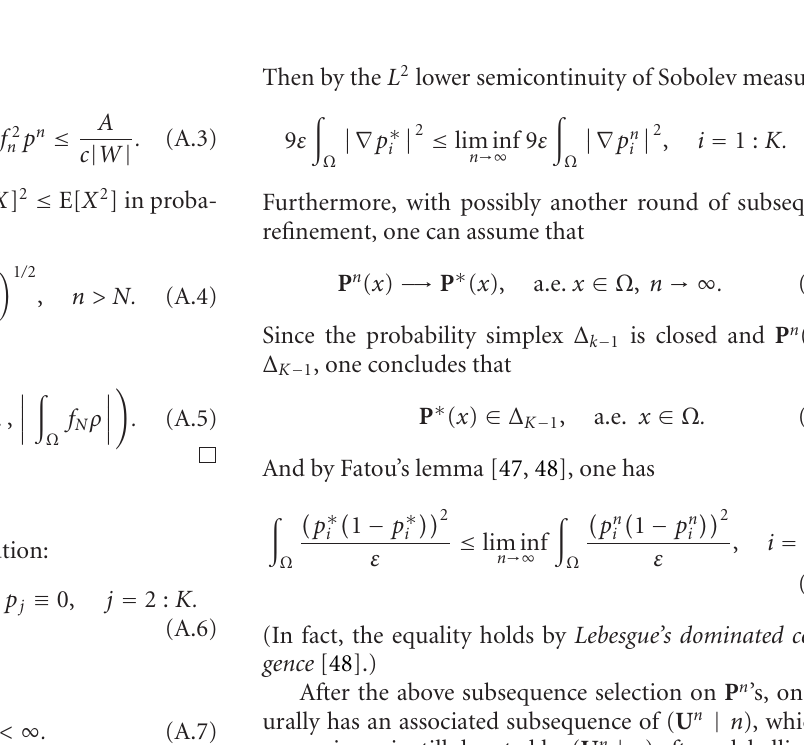
Figure 7: Hard segmentation from the SMS model via “hardening” formulae (5) and (6), based on a 2-phase supervision. Denote the two rectangles on the body by Q 1 and Q 2 , and the third by Q 3 . Supervision provides the ownership interpolation condition: p body = 1 on Q 1 ∪ Q 2 and 0 on Q 3 , while p ocean = 1 on Q 3 and 0 on Q 1 ∪ Q 2 . Patch selection can also be automated based on multiscale patch statistics (e.g., see Li and Perona